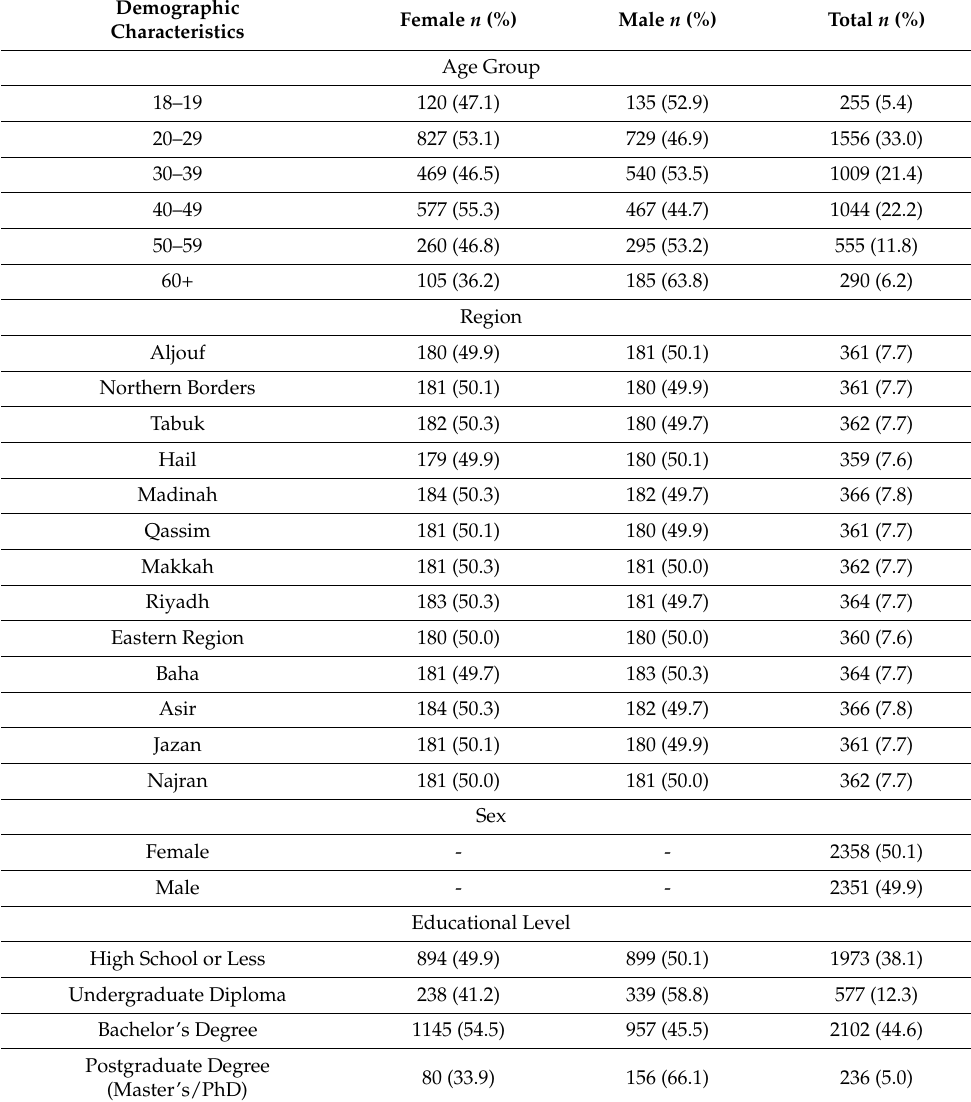
Table 1. Demographic characteristics of the participants ( n =